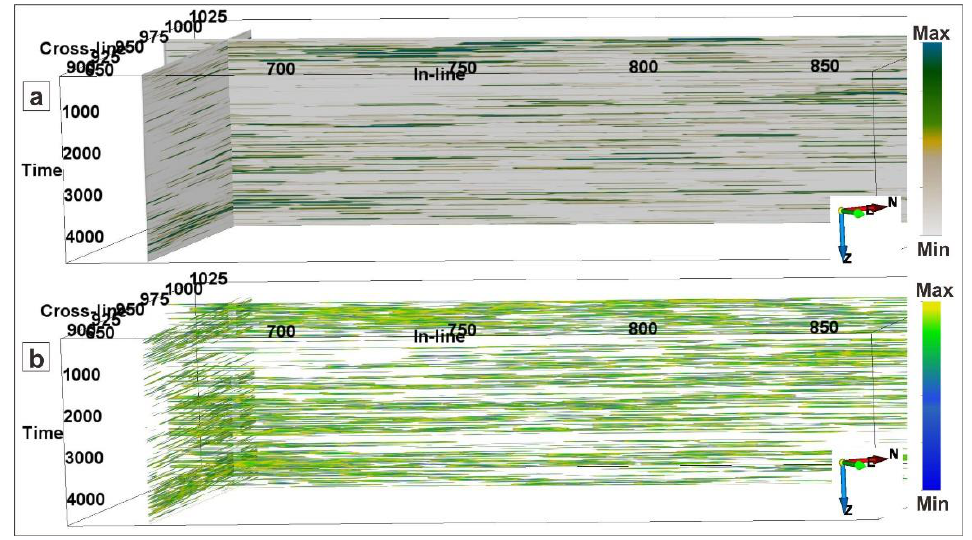
Figure 9. Seismic sections showing the dense fractured regions through ( a ) the fracture density attribute; the maximum fracture activity regions via ( b ) the fracture proximity attribute.